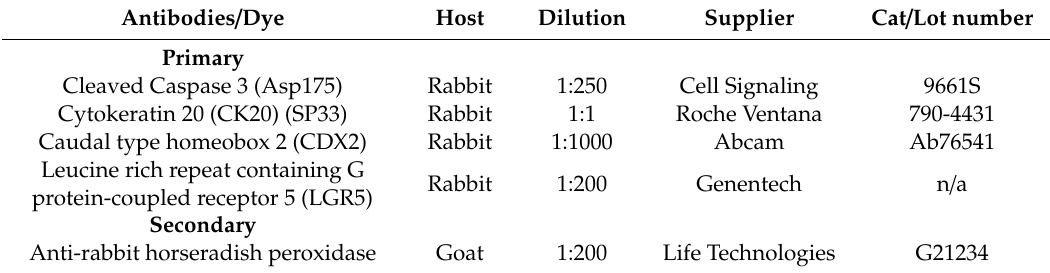
Table 1. List of antibodies used for immunohistochemistry.